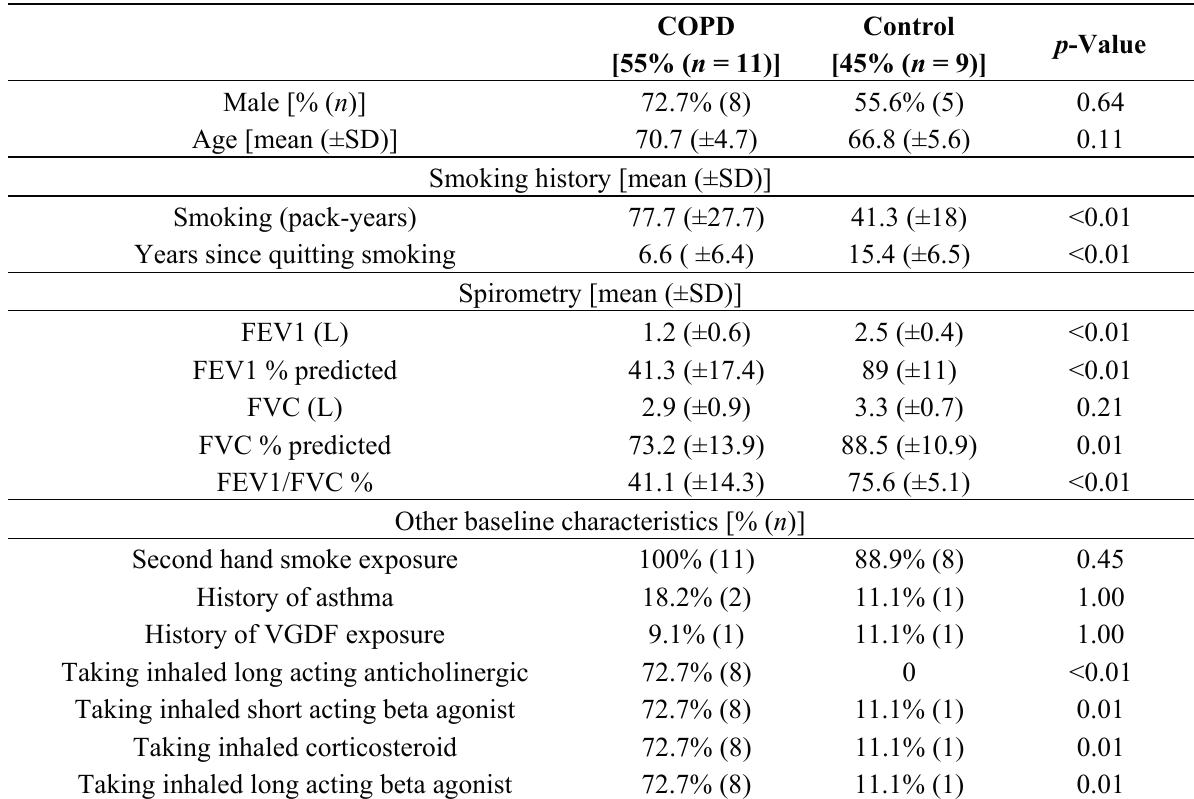
Table 3. Baseline